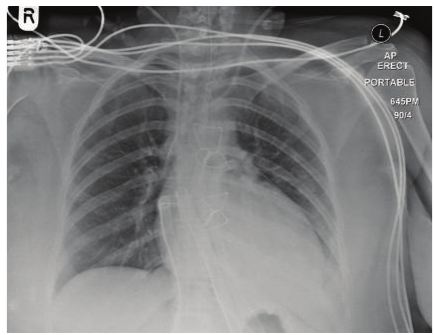
Figure 2: Chest X-ray (case one). Showing implanted